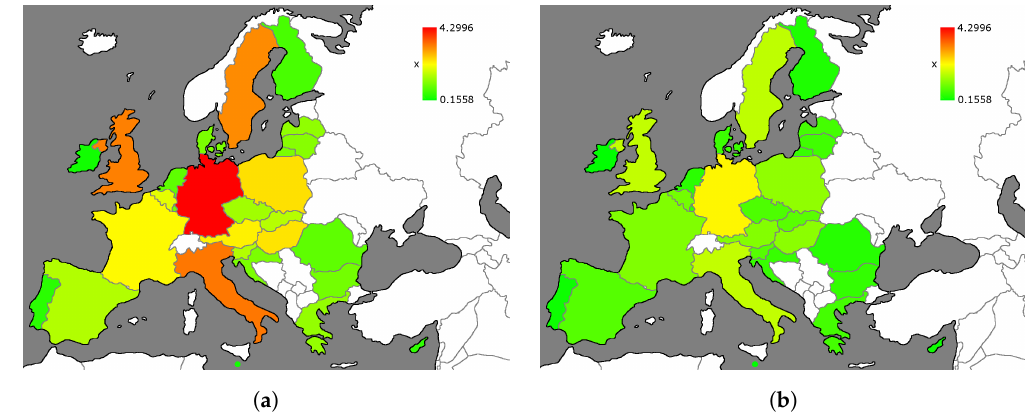
Figure 7. Overview of pollution stock for each country in relation to all other countries. Red color denotes a high amount of pollution, green color indicates a low amount of pollution. ( a ) Final pollution stock x i ( T ) per country for a basic imitation behavior after a long initial phase; ( b ) Final pollution stock x i ( T ) per country for a more advanced imitation after a long initial